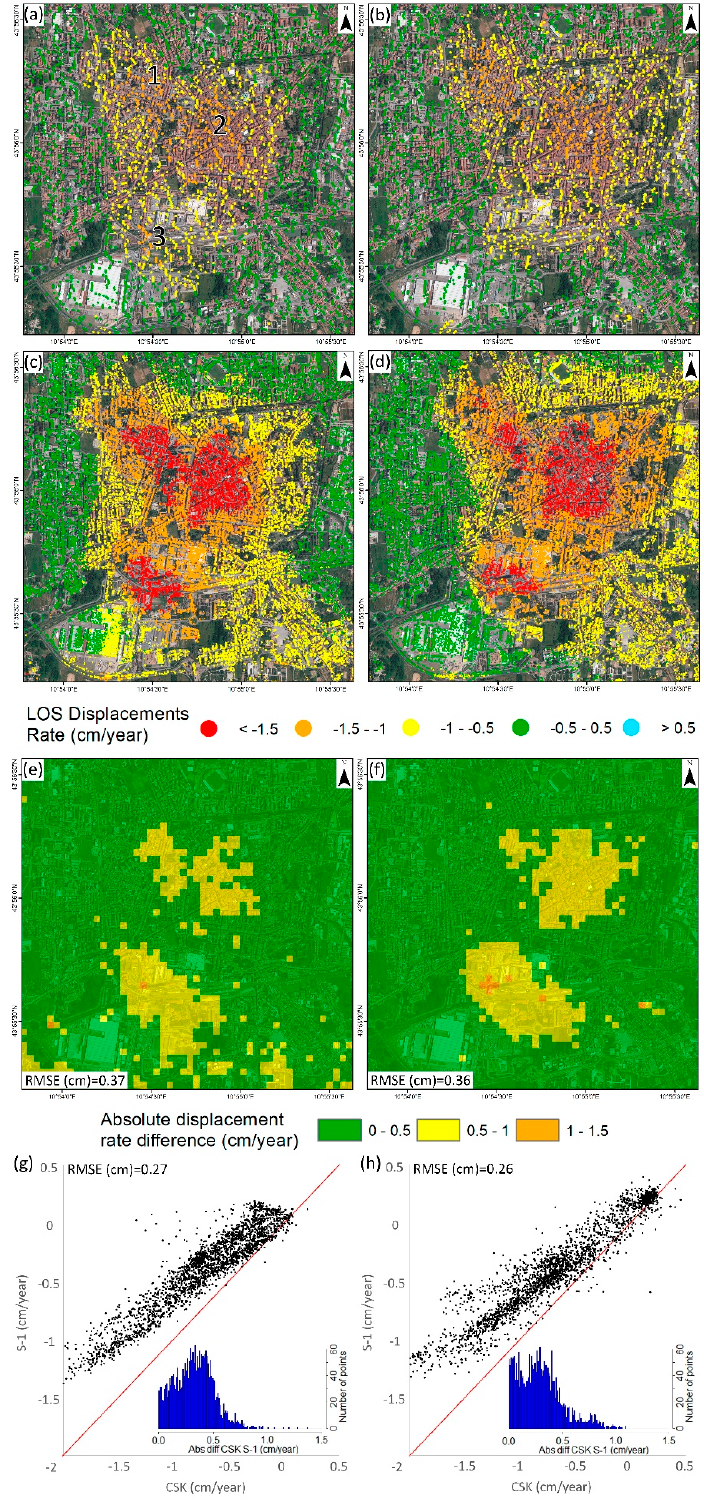
Figure 3. S-1 ascending ( a ) and descending ( b ) displacement velocities, CSK ascending ( c ) and descending ( d ) displacement velocities, spatial comparison of ascending ( e ) and descending ( f ) results and CSK-S-1 dispersion plots and histograms of ascending ( g ) and descending ( h ) geometries. Numbers in Figure 3a represent the area of the Figure 4 time series: 1 City NW, 2 City Center, 3 City SW.